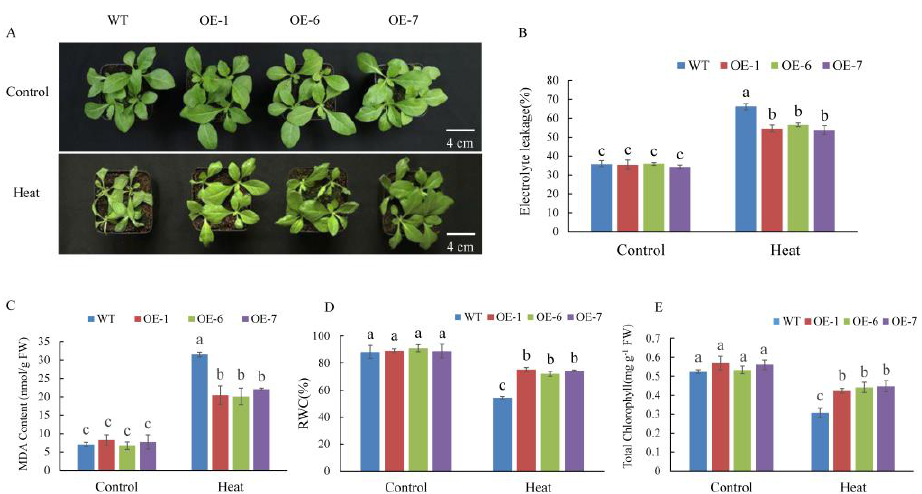
Figure 7. Overexpression of MdPRP6 confers enhanced heat tolerance to transgenic tobacco plants. ( A ) Growth phenotypes of WT and transgenic lines (Line1, Line6, and Line7) under a normal temperature and after 48 ◦ C for 6 h. ( B ) Electrolyte leakage, ( C ) malondialdehyde (MDA) concentration, ( D ) relative water content (RWC), and ( E ) chlorophyll concentration in WT and transgenic apples treated with or without high temperature. Scale bar = 4 cm. Data are means of three replicates with SD. Different letters indicate significant differences between WT and MdPRP6 transgenic plants with or without heat stress (48 ◦ C, 6 h), according to one-way ANOVA and Tukey’s multiple range tests ( p < 0.05).